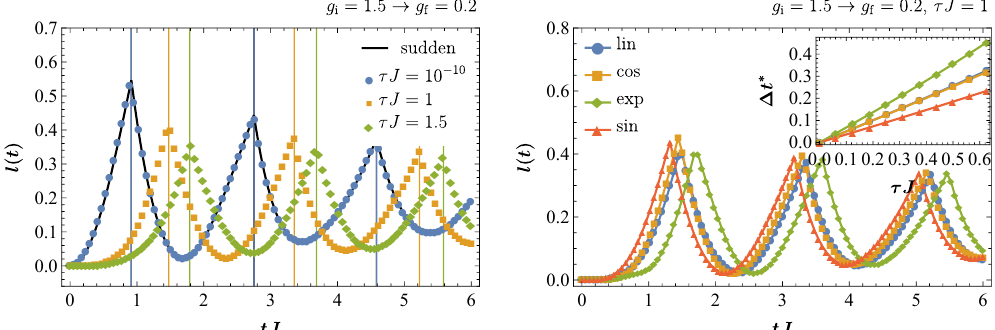
Figure 10: Left: Rate function of the return probability following linear quenches of different ( τ ) . The full line is the rate function for the sudden durations. Vertical lines are the times t (cid:63) n quench [ 52,66 ] . Right: Rate function following quenches of various protocols. Inset: Depen- dence of the offset ∆ t (cid:63) ( τ ) on the quench duration and protocol. Full lines are guides to the